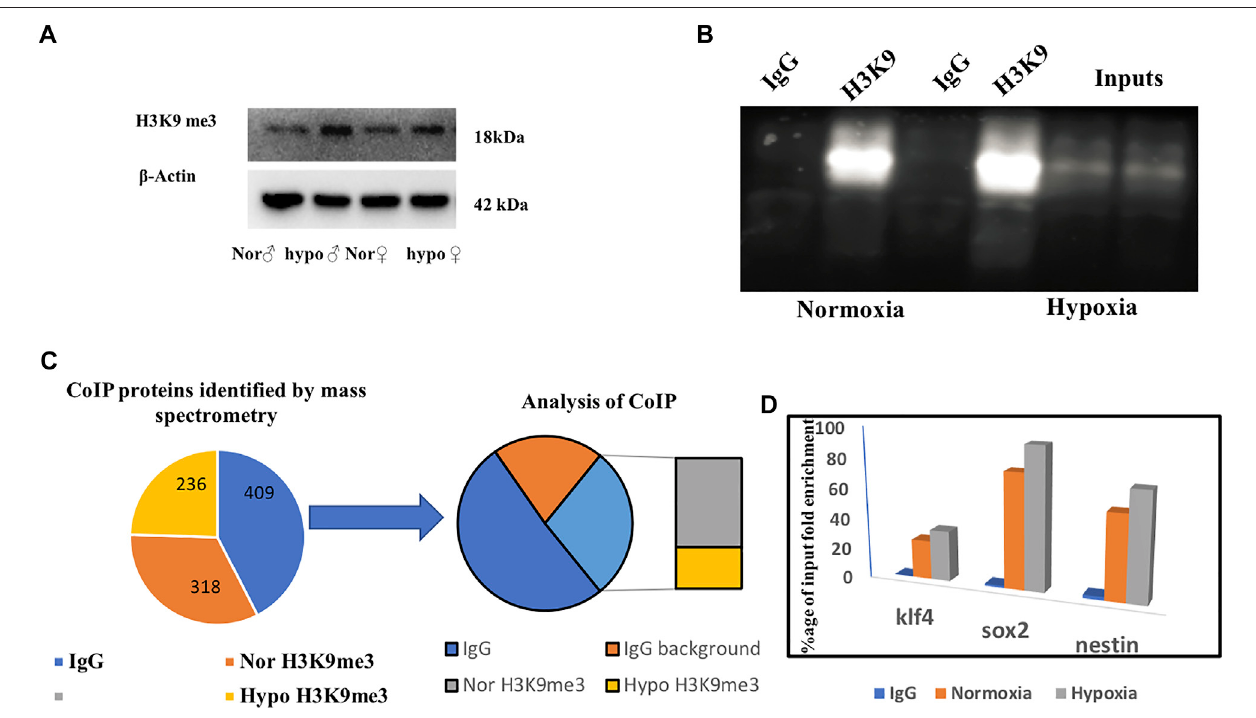
FIGURE 5 | Deciphering the role of H3K9me3 by co-immunoprecipitation. Immunoblot of H3K9me3 showing upregulation in hypoxia (A) , CoIP of H3K9me3 in zebra fi sh male brain nuclear protein (B) , Schematic representation of CoIP analysis (C) . ChIP qPCR showing H3K9 occupancy on target gene promoter. ChIP qPCR showing the increase in H3K9me3 enrichment on the promoter region of klf4, sox2, and nestin in hypoxic male brain (D)